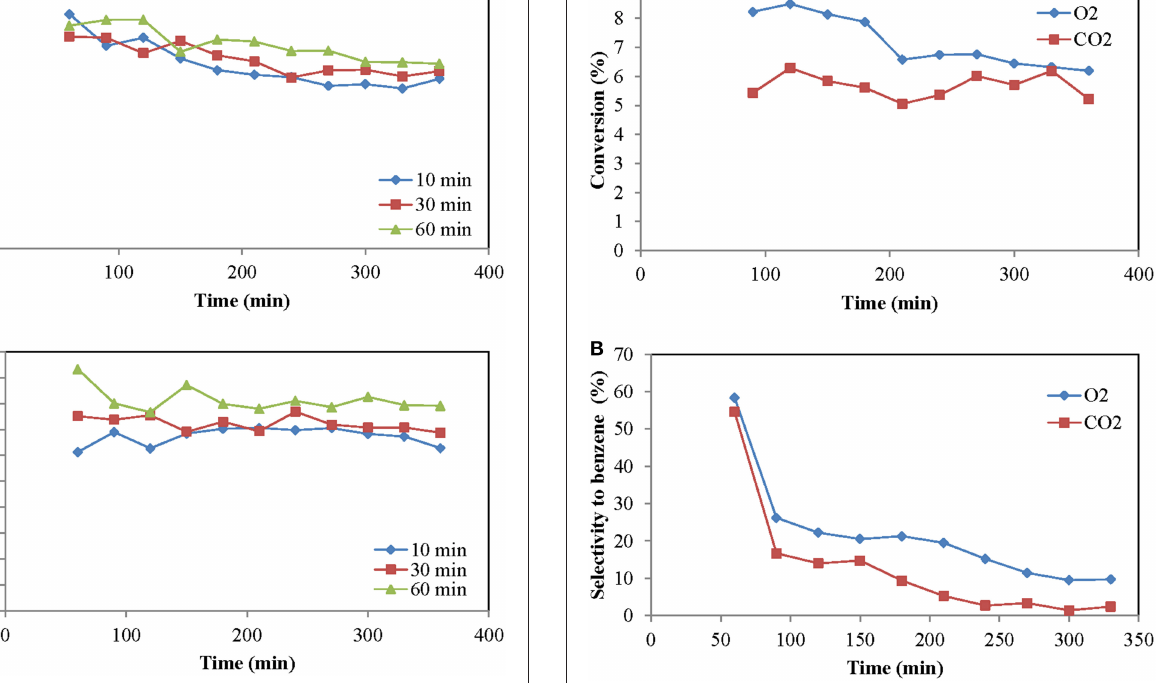
FIGURE 4 | Influence of the oxidant type (time on stream): (A) Methane conversion, (B) selectivity to benzene. Operating conditions: W cat = 12g, CH 4 :O 2 :N 2 = 70:2:28 and CH 4 :CO 2 :N 2 = 70:4:26, u rlowerzone = 2.5, u rupperzone = 10.8 and T = 700 ◦